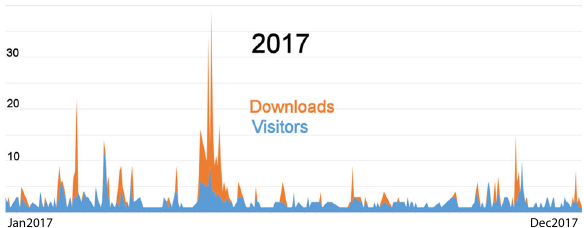
Fig. 8 KCDC access statistics for 2017. The peaks correspond to KCDC presentations at conferences